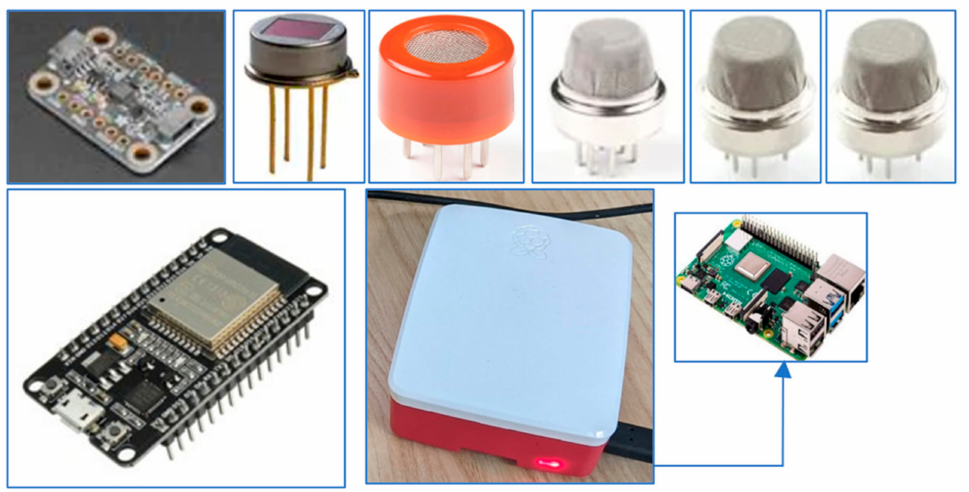
Figure 3. Top (from left to right): the sensors used (SHTC3, TO-39, MQ-9B, MQ-2, MQ-6, and MQ-4). Bottom left: the microcontroller unit (ESP32). Bottom right: the edge gateway (Raspberry Pi